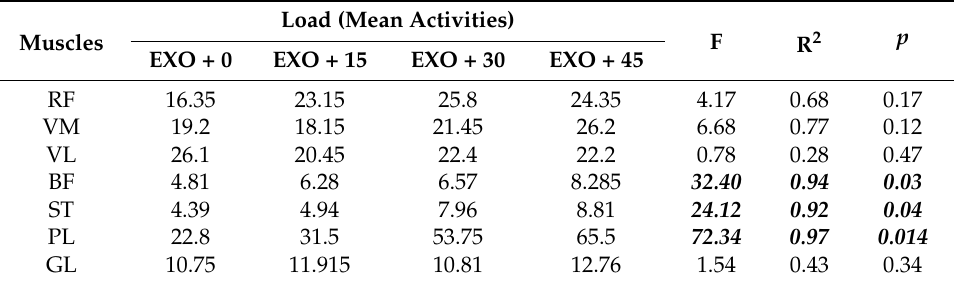
Table 2. Mean Muscle Activities During 0 kg, 15 kg, 30 kg, and 45 kg Load Levels With the Exoskeleton. (Note: The determination coefficient R 2 and the statistics F of Fischer used to confirm the linearity in whole cases are shown. The bold and italic style indicates linearity.).